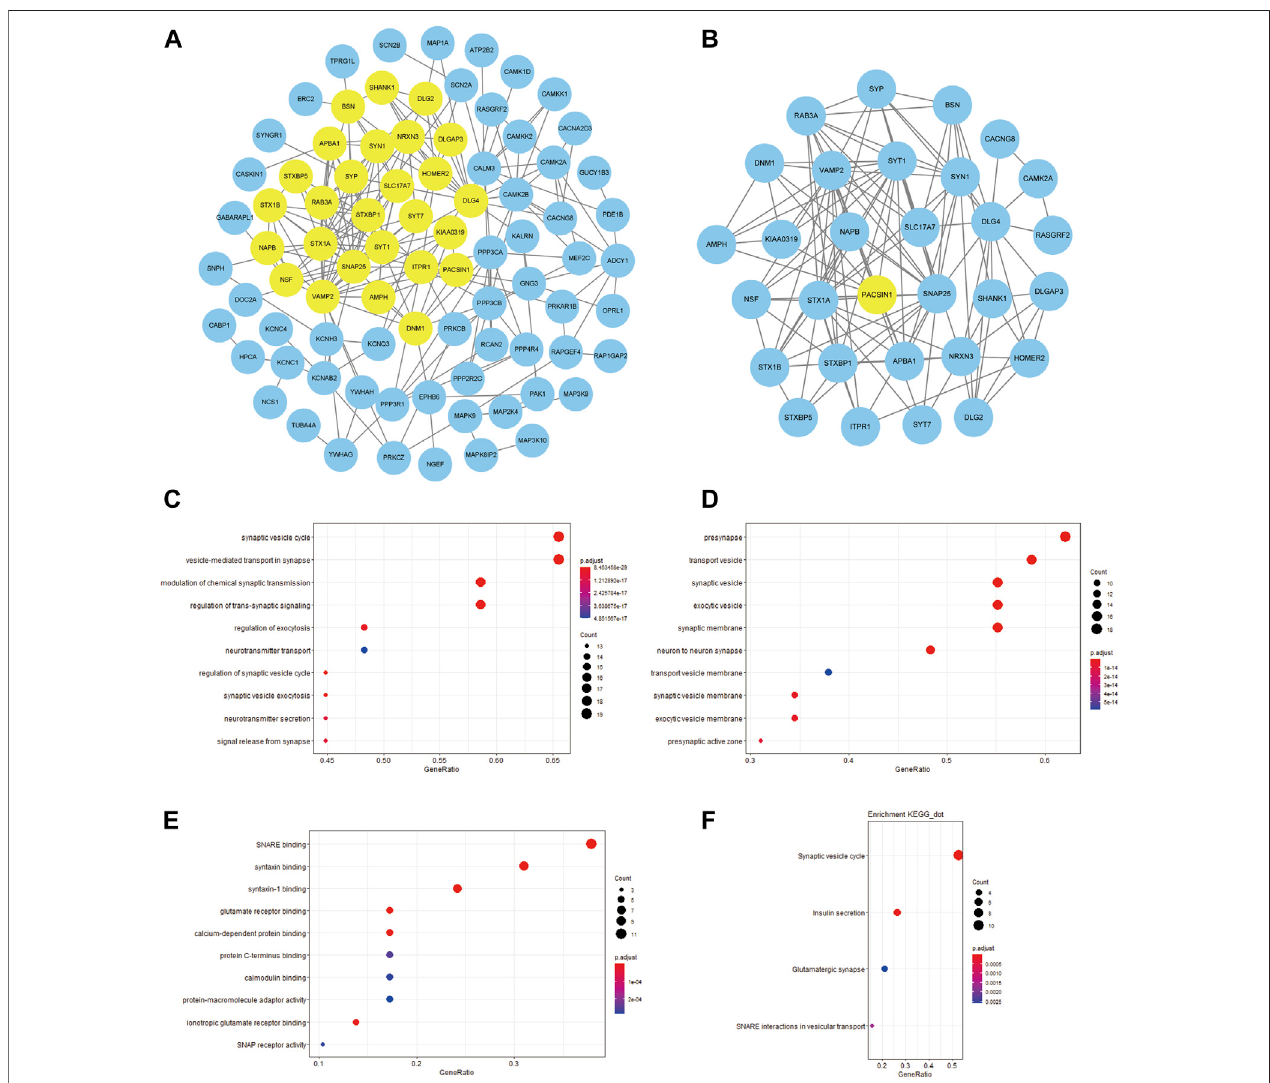
FIGURE8| PPInetworkbetweenPACSIN1andDEGsandtheenrichmentanalysisofthemaingenecluster.ThePPIwith84nodesplus223edgeswasprocessed withCytoscapev.3.8.0,andthemaingeneclusteranalysedbyMCODEwascoloredbyyellow (A,B) .ThemaingeneclusterinGOenrichmentanalysisresultsBP (C) ,CC (D) , MF (E) , KEGG enrichment analysis results (F)